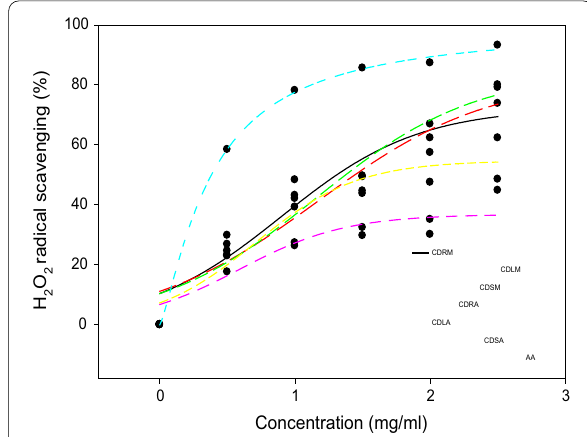
Fig. 5 Ferric reducing antioxidant power (FRAP) of crude aqueous and methanolic extracts of leaves, stem and roots of Chasmanthera dependens and ascorbic